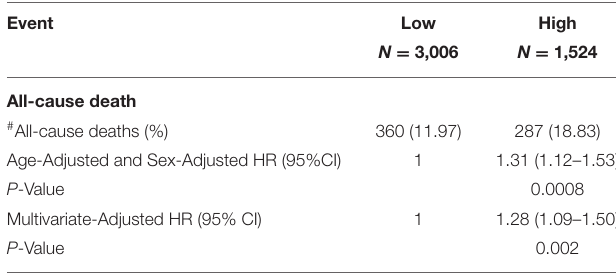
Deaths in the 10-year follow-up period were calculated using Cox-proportional Hazards Model. Variables included in the multivariate analysis consisted of age, sex, systolic blood pressure, diastolic blood pressure, BMI, smoking status, hypertension, diabetes mellitus, hyperlipidemia, and chronic kidney disease. Low EA is defined as < = 1 ECG abnormalities, and high EA is defined as > = 2 ECG